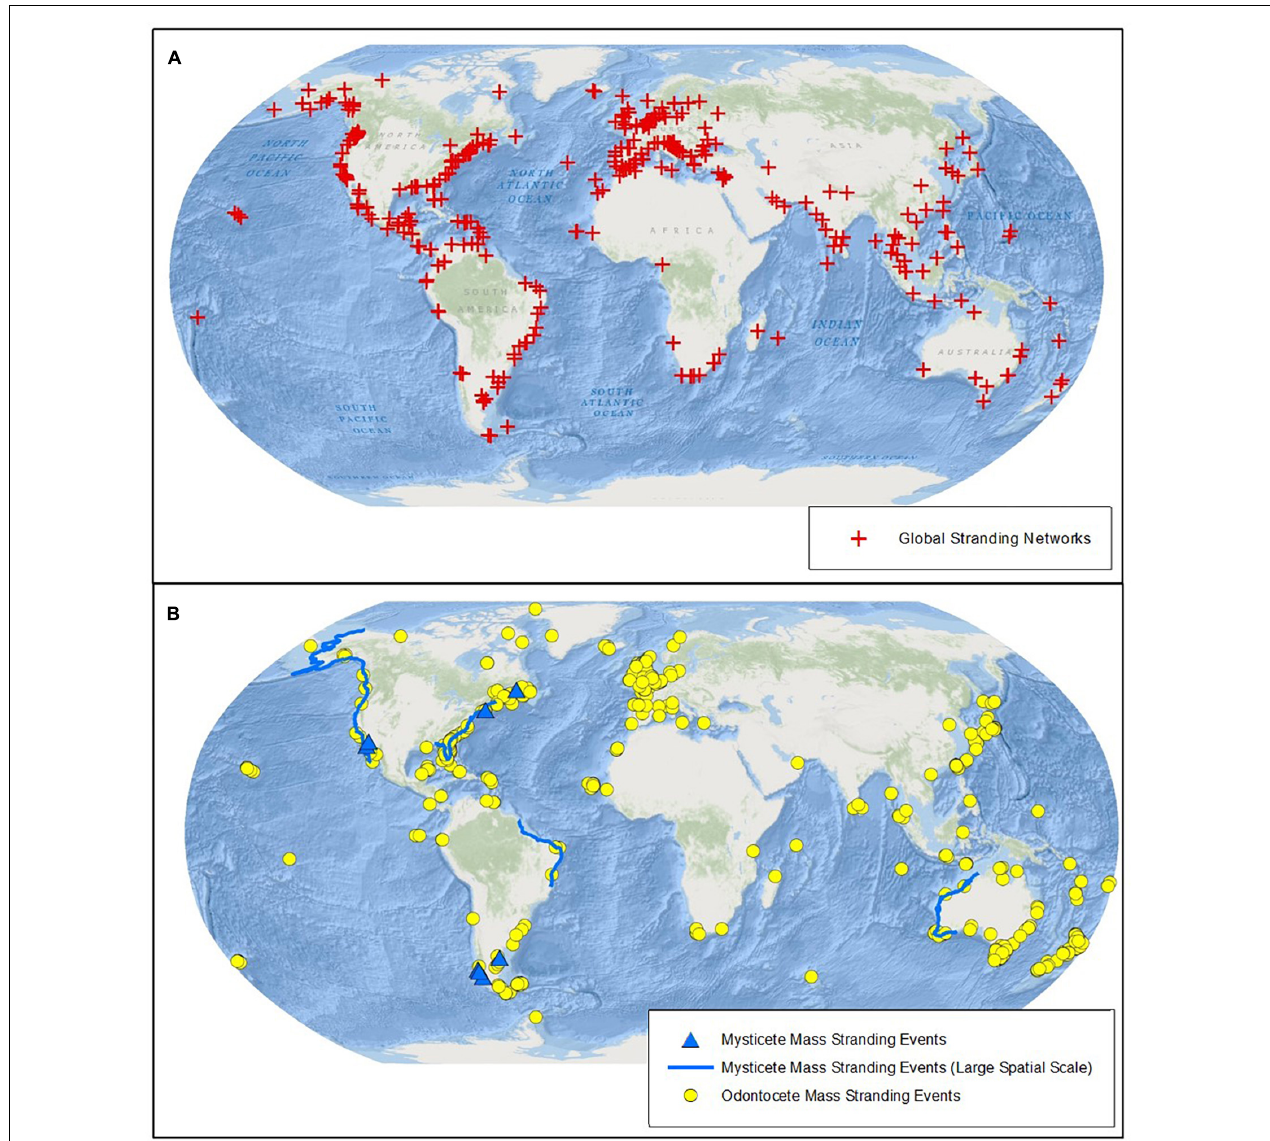
FIGURE 1 | Global stranding patterns and networks, (A) shows global stranding networks (red cross) and (B) shows cetacean mass mortality events globally. Yellow circles show odontocete mass stranding events with 10 or more individuals (summary data reproduced from Hamilton, 2018); Blue triangles and lines show baleen whale mass mortality events (updated from Table 1 in Häussermann et al., 2017). Triangles represent events with a known and specified location and lines represent events with only a known country level location or UME’s that occurred over large coastal areas (a single line can depict several events in the same location, individual event data is shown in Supplementary Table 2 ). Events of unknown or unspecified locations are not mapped. All data was up to date as of the 2nd September 2020. Base map source: ESRI, GEBCO, NOAA, National Geographic, Gamin, HERE, Geonames.org, and other contributors Esri, Garmin, GEBCO, NOAANGDC, and other